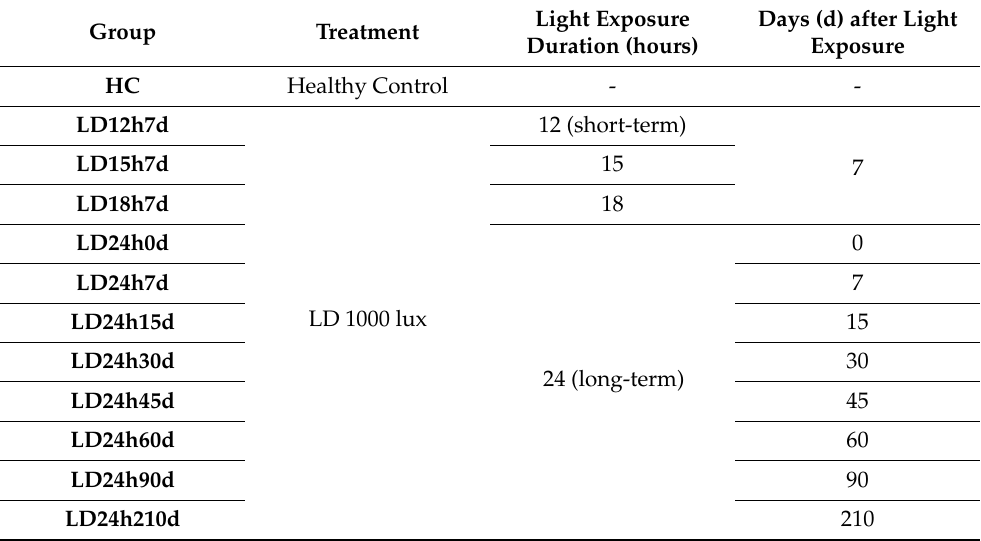
Table 1. Experimental